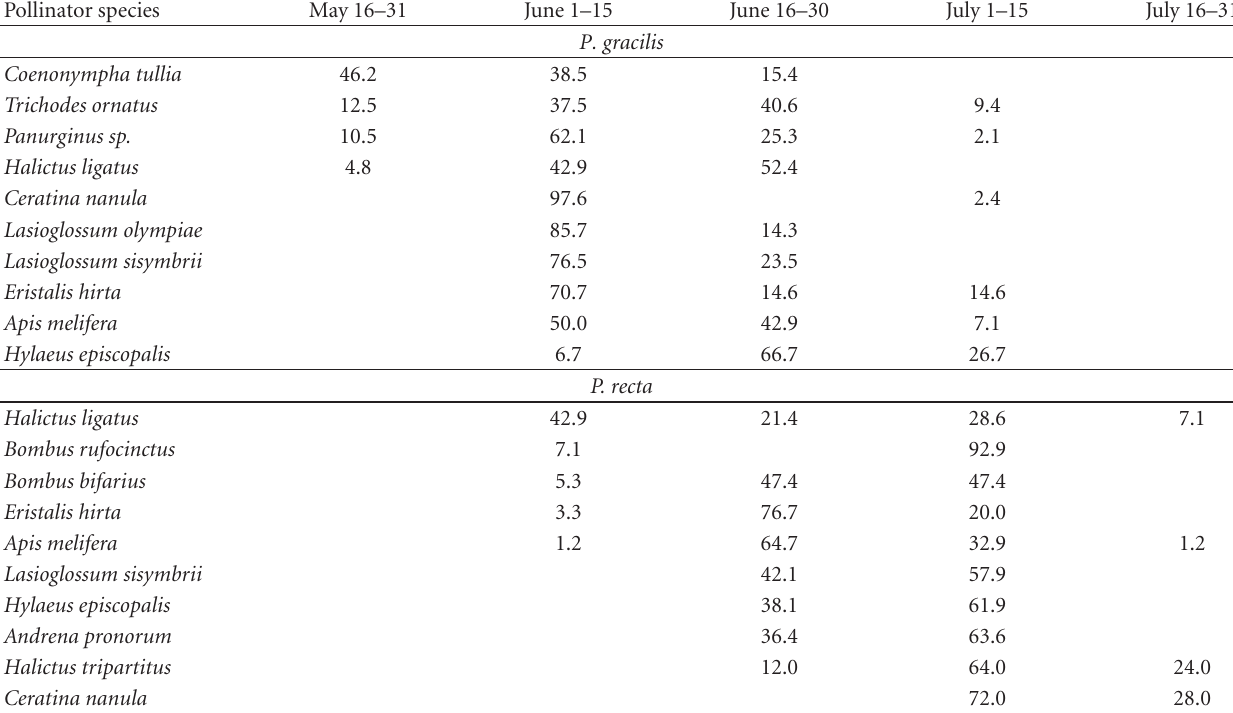
Table 2: Phenology of ten most commonly observed flower visitors of Potentilla gracilis (native) and P. recta (exotic), at four sites in Northeastern Oregon, 2002–2004.